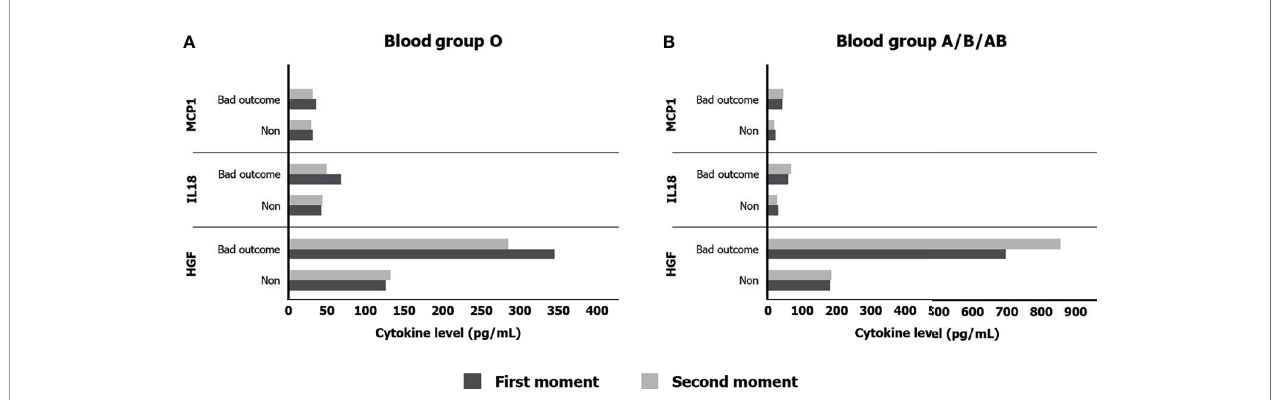
FIGURE 4 | Signi fi cant cytokines levels according to bad outcome (intubation or death) in O blood group (A) and their expression in A/B/AB blood group patients (B)